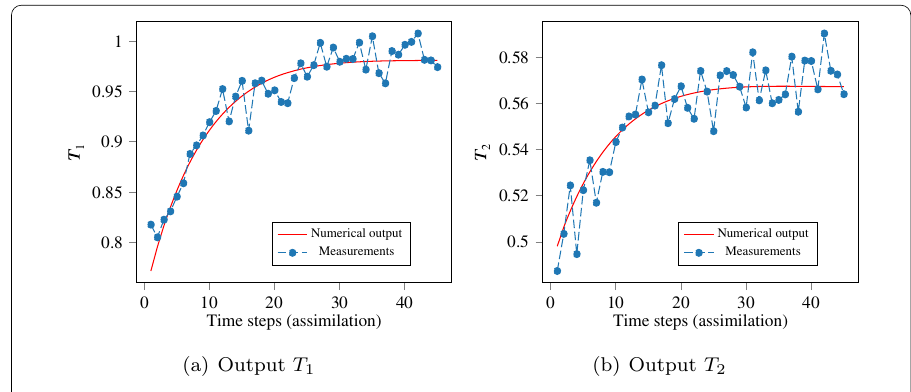
Fig. 9 Measurements simulated with the numerical model, when the control is not activated - Case